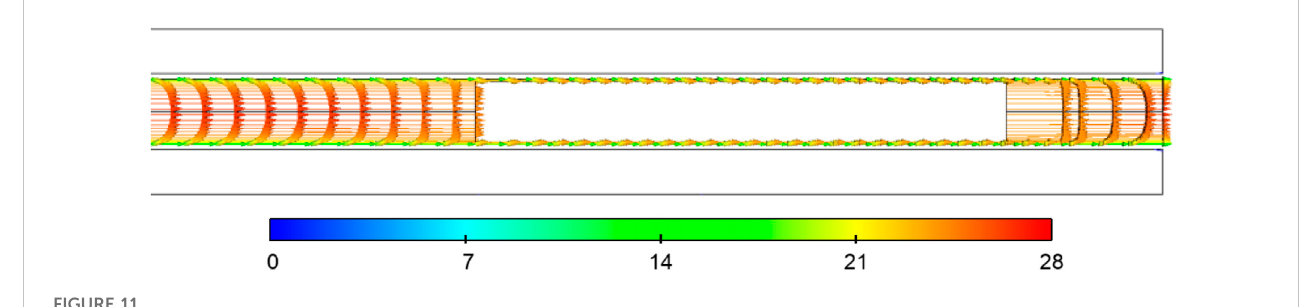
FIGURE 11 Speed fi eld in plunger-tubing clearance (m/s).